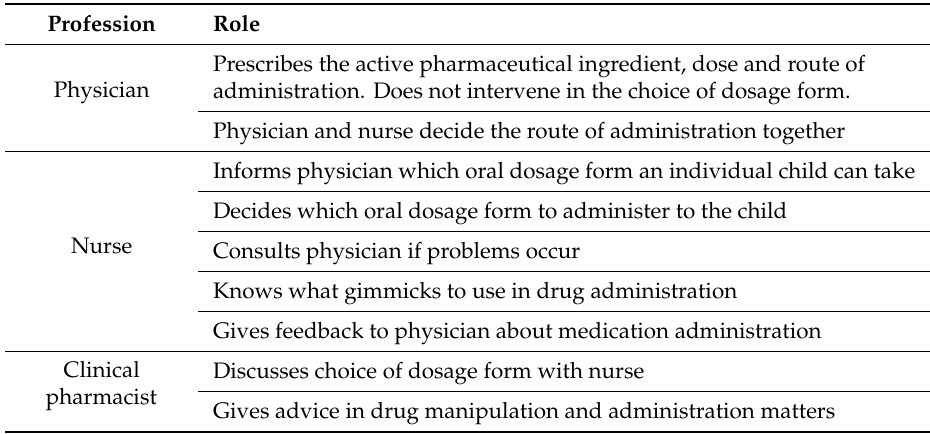
Table 5. The roles of di ff erent healthcare professionals in prescribing and administering oral medicines at hospital